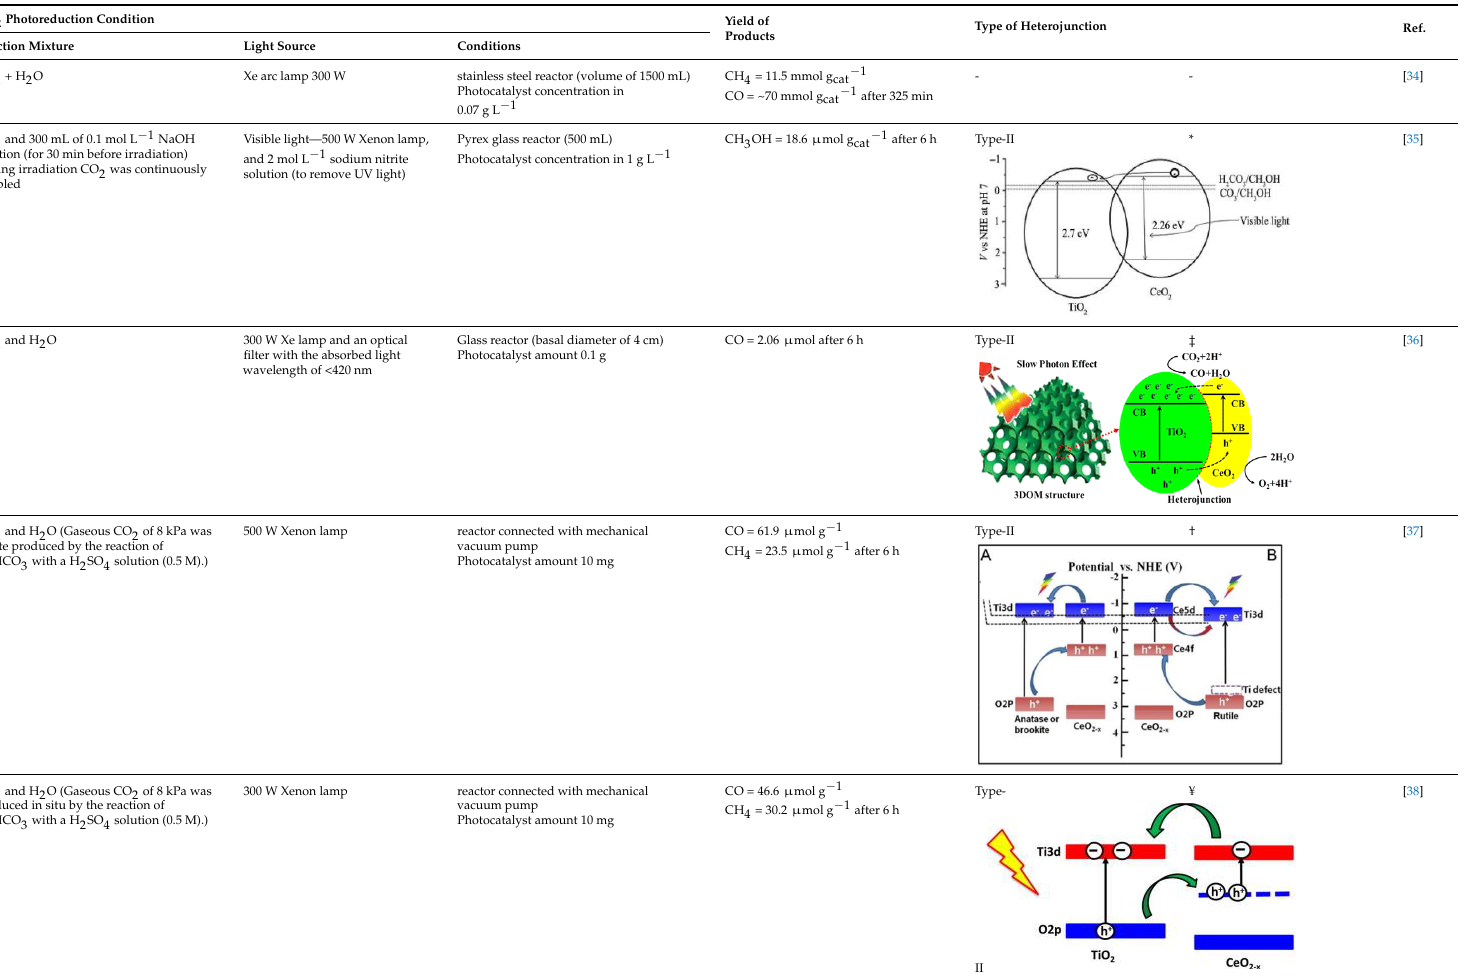
Table 3. CO 2 photoreduction using CeO 2 /TiO 2 heterojunction photocatalysts.